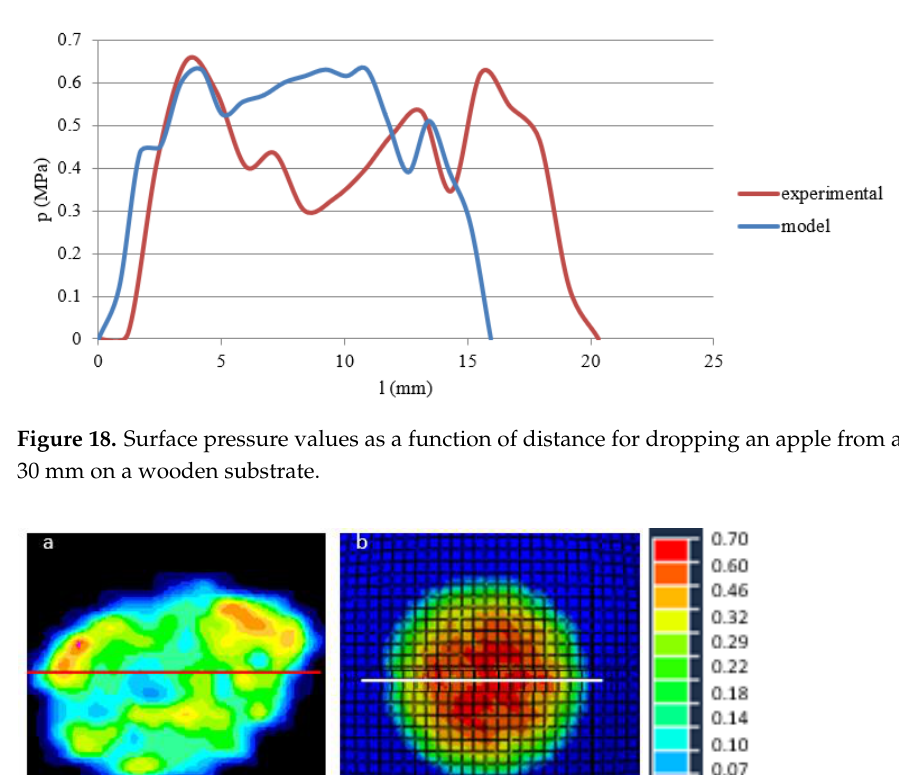
Figure 17. Layers and surface pressure distributions of the real object ( a ) and model object ( b ) for an apple dropped from a height of 10 mm on a wooden substrate in a section passing through the central point of contact.